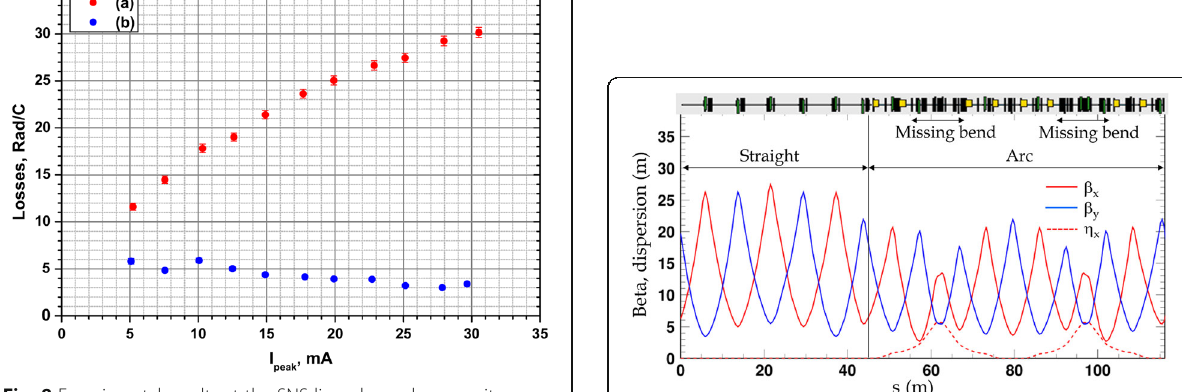
Fig. 8 Experimental results at the SNS linac; beam loss monitor signals (normalized by beam charge) vs peak current for H − ( a ) and protons ( b ) [10]